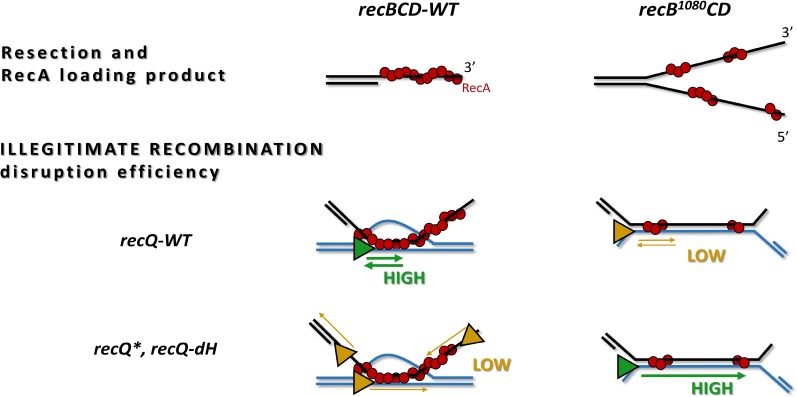
Functional fine-tuning between RecBCD and RecQ enzymes.Upper row: DSB processing by the RecBCD-WT complex (RecBCD protein not shown) results in RecA-loaded 3’ DNA overhangs. In contrast, RecB1080CD produces aberrant long, partially RecA-filled 5’ and 3’ overhangs. Middle row: The complex DNA unwinding, directed invasion disruption and shuttling activities of the RecQ-WT enzyme (triangle) enable efficient disruption of IR invasions (green) in the recBCD-WT, but low efficiency (yellow) in the recB1080CD background. Lower row: The enhanced (highly processive) DNA unwinding, but compromised directed invasion disruption and/or shuttling activities of RecQ* and RecQ-dH enzymes (triangle) are inefficient (yellow) for IR disruption in the recBCD-WT background. However, these activities become efficient (green) in the recB1080CD background where HR is more likely proceed through joint DNA molecules of aberrant structure.